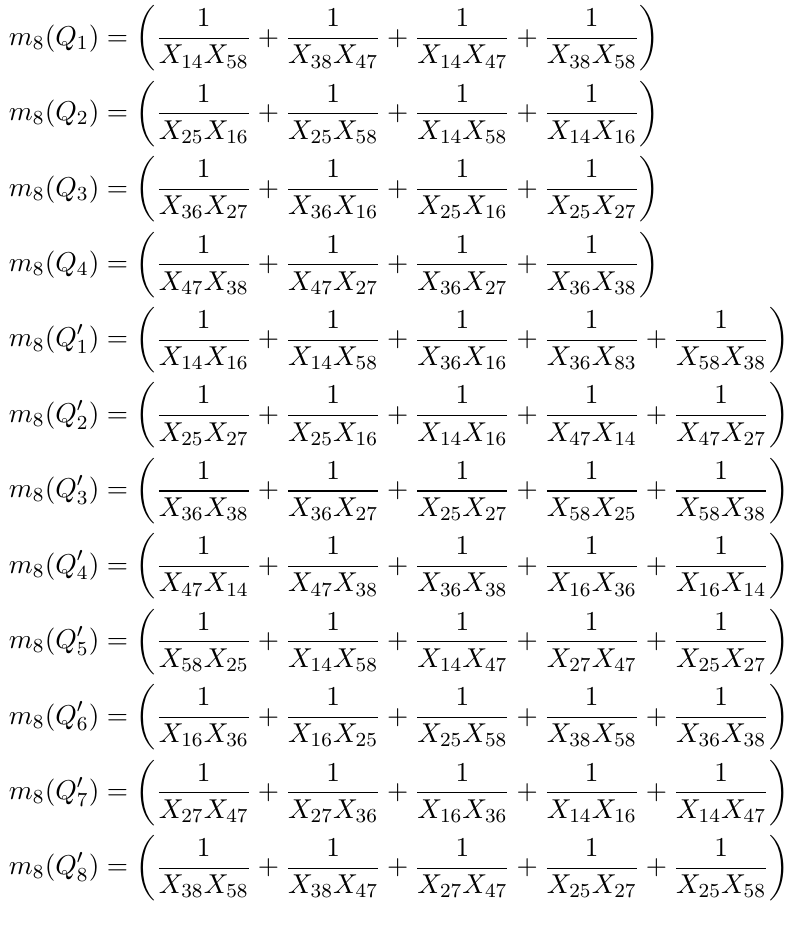
j ; j i ; i j ; : : : g 1 1 1 2 2 3